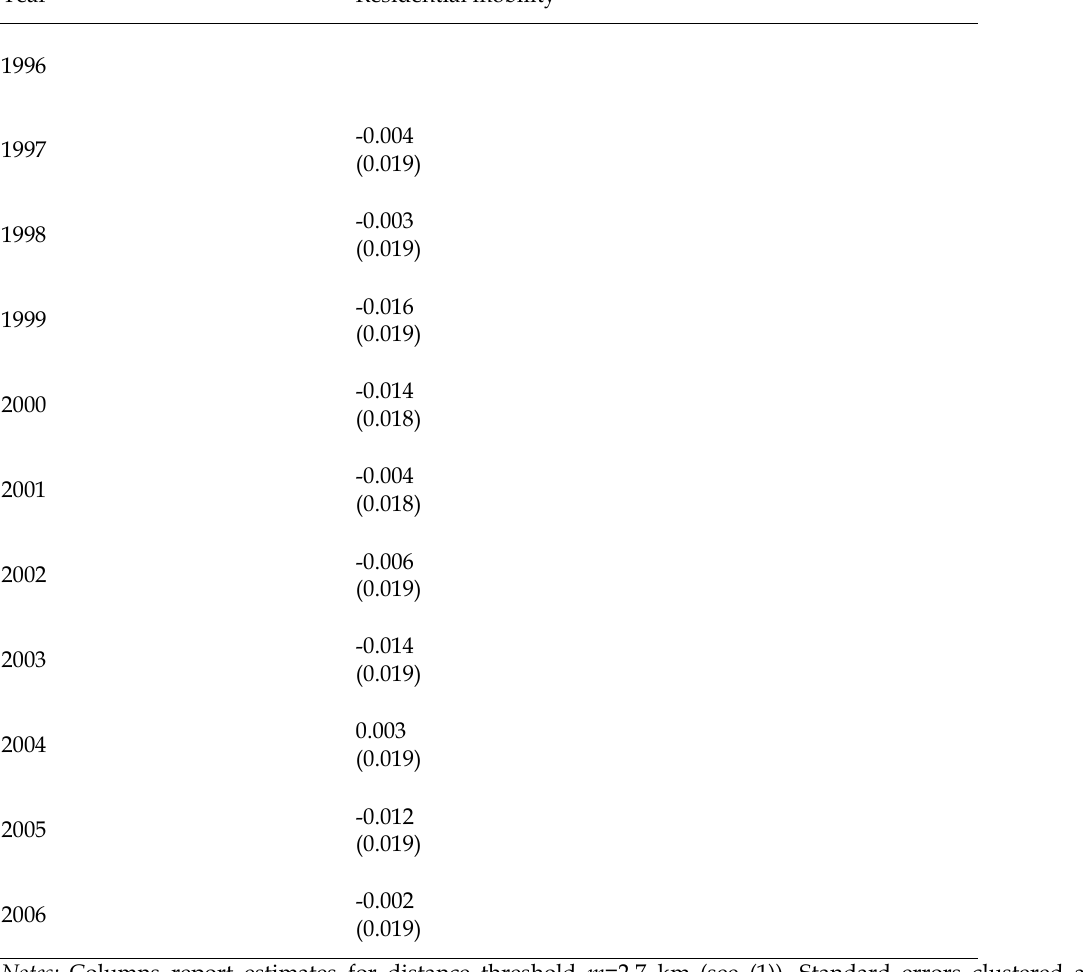
Table A3. Estimated pre- and post-treatment effects of improved job accessibility on mobility of individuals employed in the trade, transport, restaurant or hotel